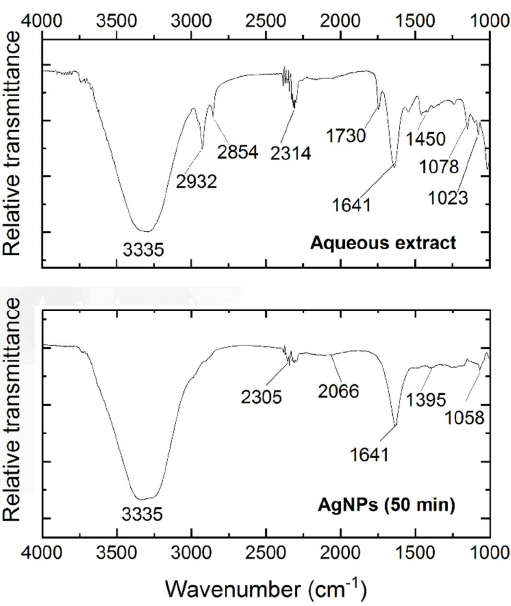
Figure 4. FTIR spectra of aqueous extract of Thuja orientalis and AgNPs obtained at 50 min of syn- thesis.